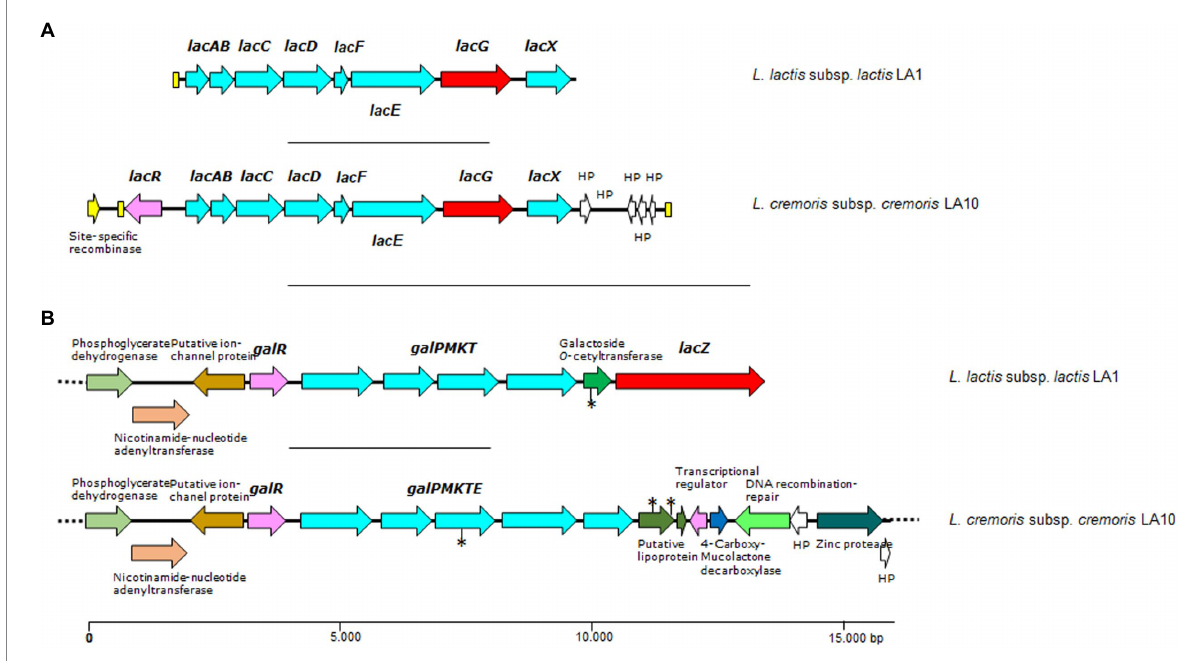
FIGURE 3 Genetic organization of lactose/galactose gene clusters ( A and B ) found in the genome of L. lactis LA1 and L. cremoris LA10 isolated from a naturally fermented milk. Color code: in red, genes coding for β -galactosidases, lacZ , or phospho- β -galactosidase, lacG ; in pale blue, genes and components of carbohydrate transporter and metabolism; in yellow, open reading frames (ORFs) encoding transposases or mobilization proteins; in purple, genes coding for regulatory proteins. Yellow boxes indicate DNA repeats, and the asterisks denote ORFs containing mutations disrupting the gene. Dotted lines indicate that the contig extends beyond the depicted area.